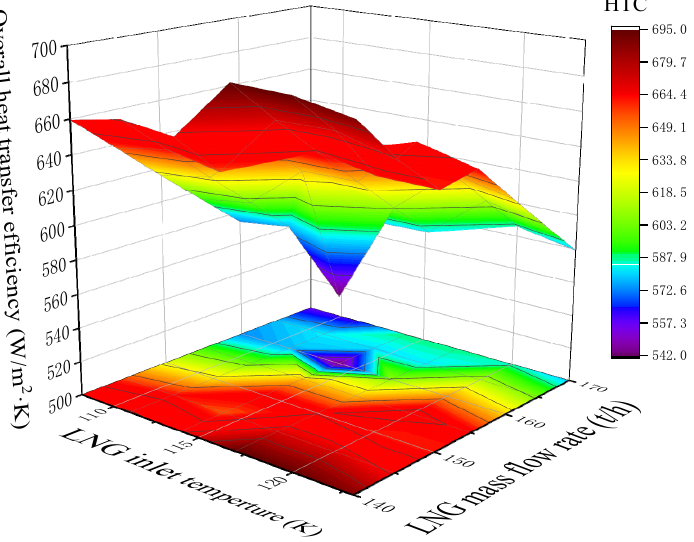
Figure 9. Surface heat transfer coefficient at different LNG inlet temperatures.